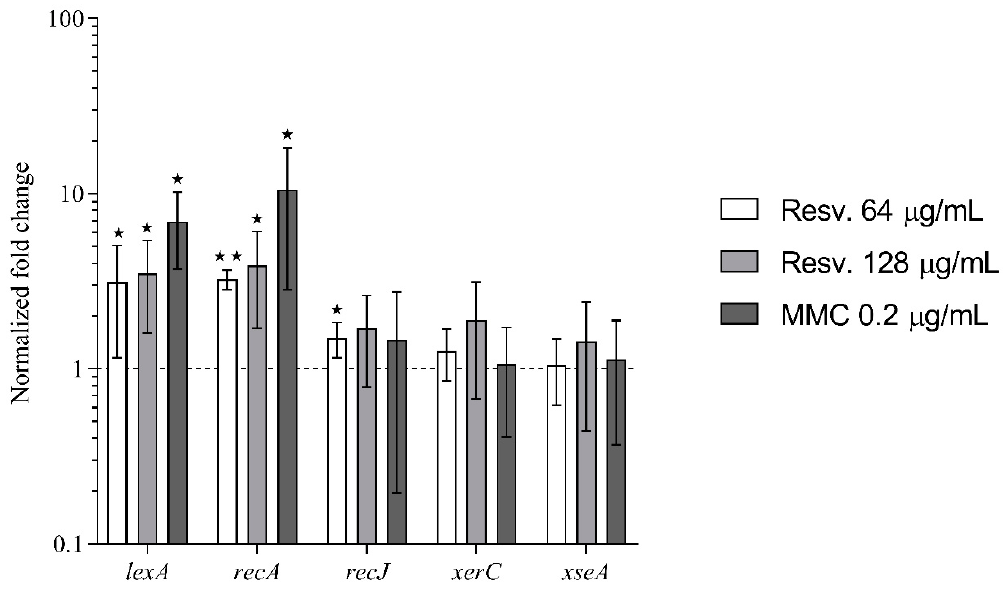
Figure 2. Effect of resveratrol on the expression of DNA repair– and SOS–stress response genes. qPCR was used to measure alterations in gene expression of lexA , recA , recJ , xerC and xseA in S. aureus JE2 cells grown in the presence of resveratrol (0.25 × or 0.5 × MIC) or mitomycin C (0.5 × MIC) relative to untreated cultures. Each column represents the mean of at least three biological replicates. Error bars represent 95% confidence intervals. ★ p < 0.05 and ★★ p < 0.01.